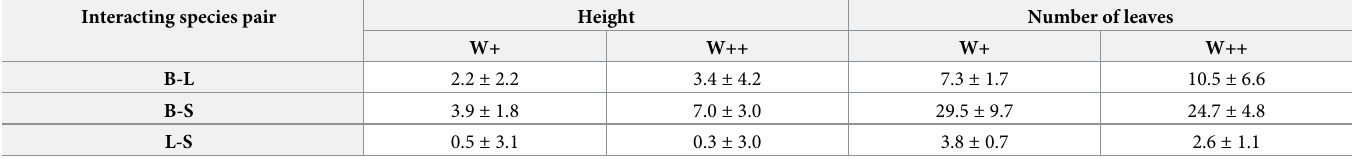
Table 2. Competition asymmetry on plant height and number of leaves for the three pairs of interacting species. Interacting species pair